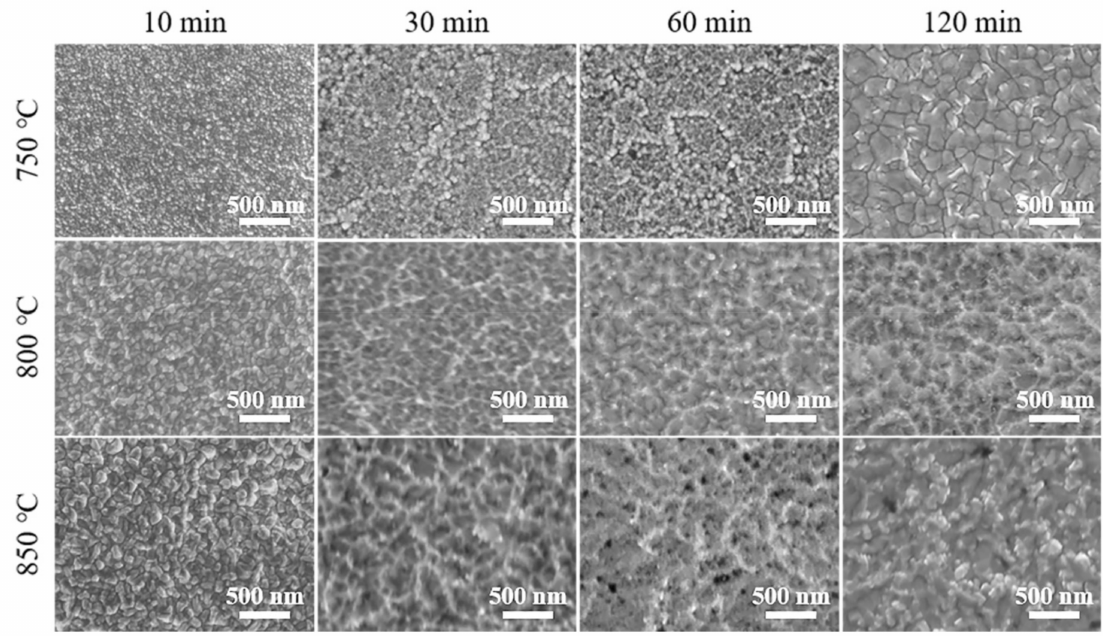
Figure 1. SEM images of Ta coatings prepared at 750, 800, and 850 ◦ C for 10, 30, 60, and 120